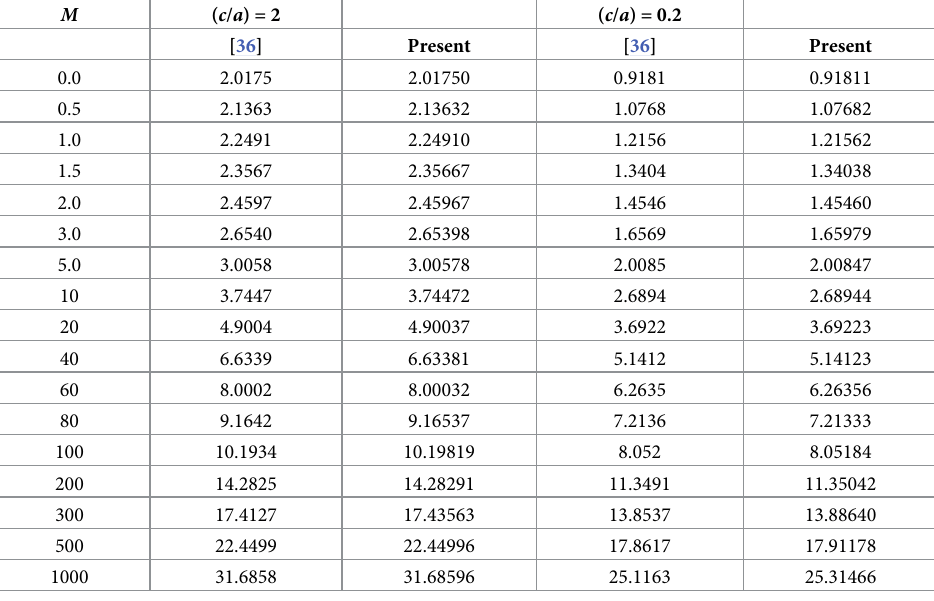
Table 2. Comparison of velocity gradient | F @ (0)|with that of Mahapatra et al. [36] when β = λ = 0. M ( c / a ) = 2 ( c / a ) = 0.2 [36] Present [36] Present